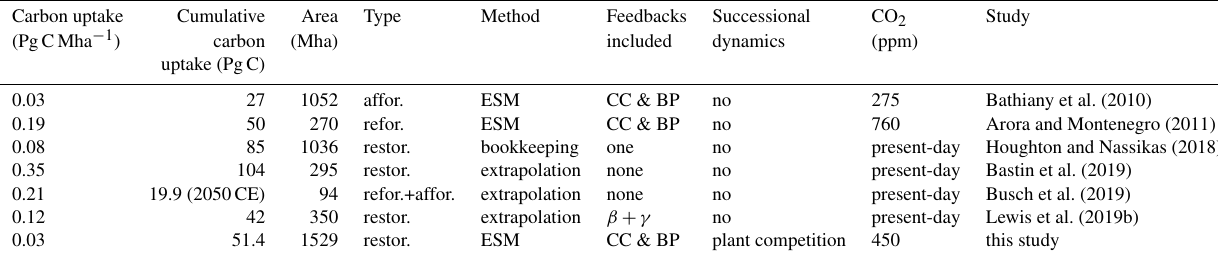
Table 3. Carbon uptake estimates for tropical afforestation (affor.), reforestation (refor.), and forest restoration (restor.), normalised by area, cumulative uptake by 2100CE, renaturalised area, type of renaturalisation strategy, and method for calculation, whether carbon cycle feedbacks (CC), biogeophysical feedbacks (BP), CO 2 fertilisation ( β ), or plant temperature responses ( γ ) were included; successional dynamics; and CO 2 concentrations in control experiments. ESM represents Earth system model. All values are for tropics only (tropics as specified by each study), except Lewis et al. (2019b) includes some extratropical regions under the Bonn Challenge. Note that Arora and Montenegro (2011) uses the term afforestation for turning present-day cropland that would be forest back into forest; here we label this